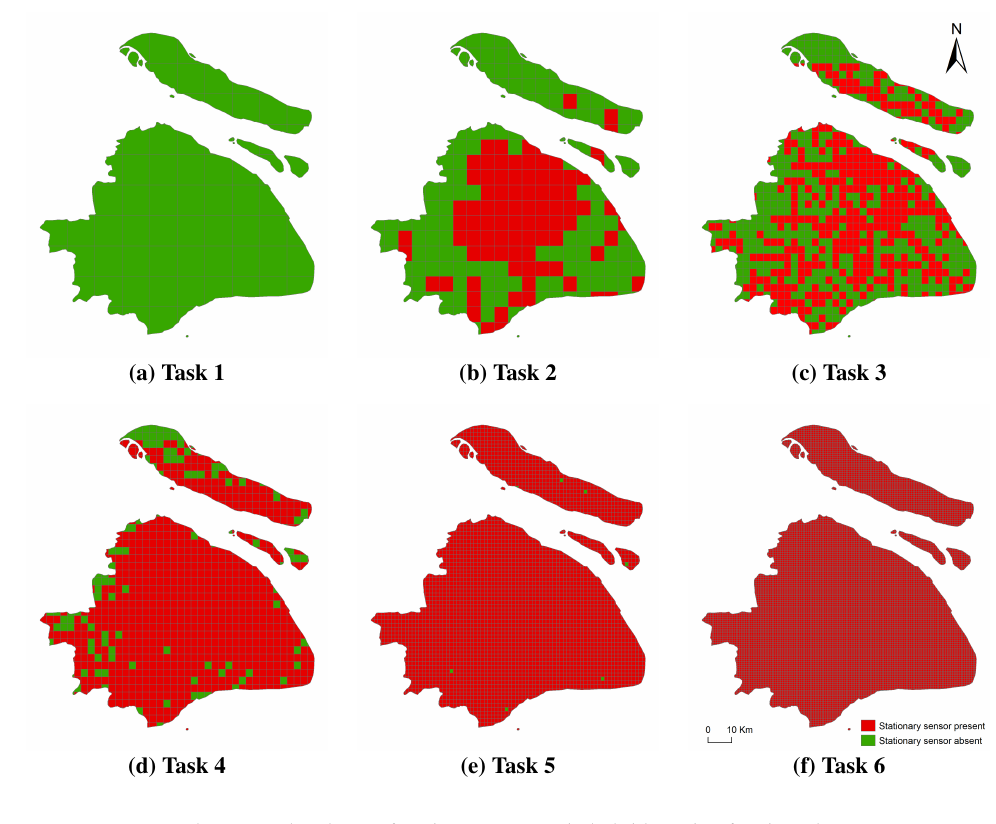
Figure 5. The places of stationary sensors in hybrid sensing for six tasks.